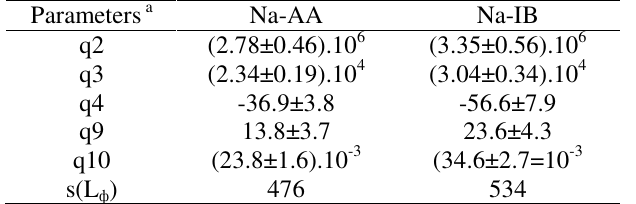
, for calculating the L i